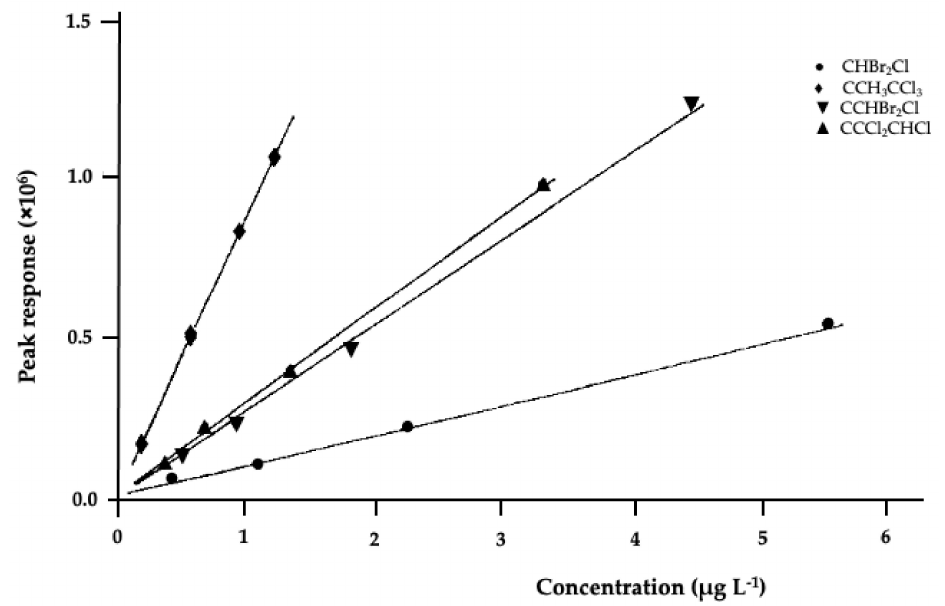
Figure 2. Calibration curves of CH 3 CCl 3 , CCl 2 CHCl, CHBrCl 2 and CHBr 2